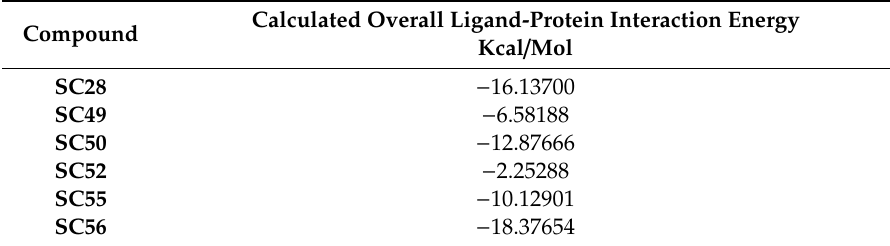
Table 2. Calculated Overall Ligand-Protein interaction energies for the novel azabicyclohexane